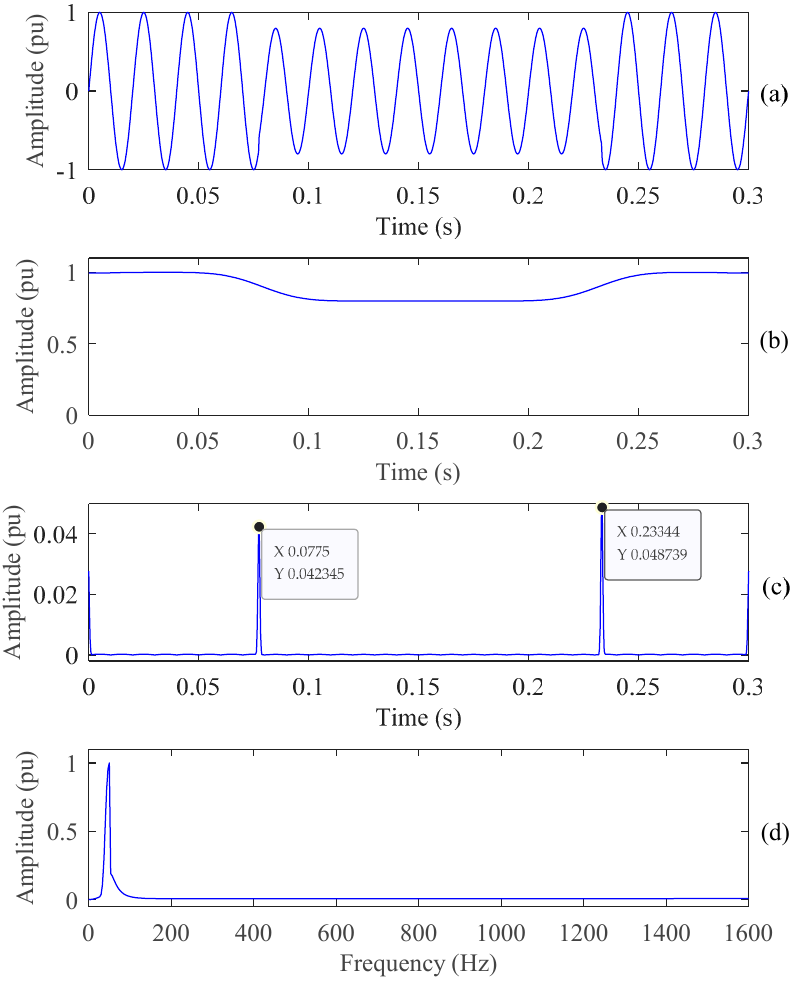
Figure 3. Voltage sag and related STA : ( a ) Voltage sag; ( b ) TvA ; ( c ) TvHFA ; ( d ) FvA.